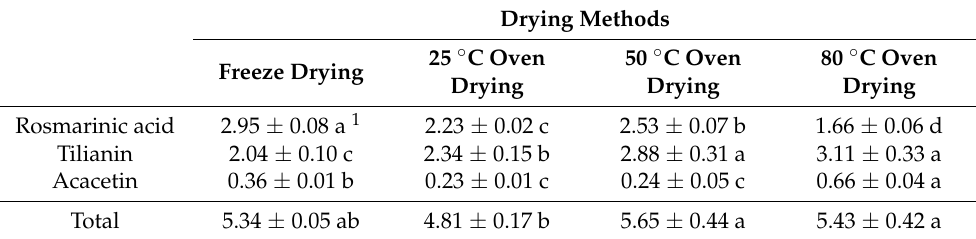
Table 1. The contents of rosmarinic acid, tilianin, and acacetin after different drying conditions (mg/g dw).